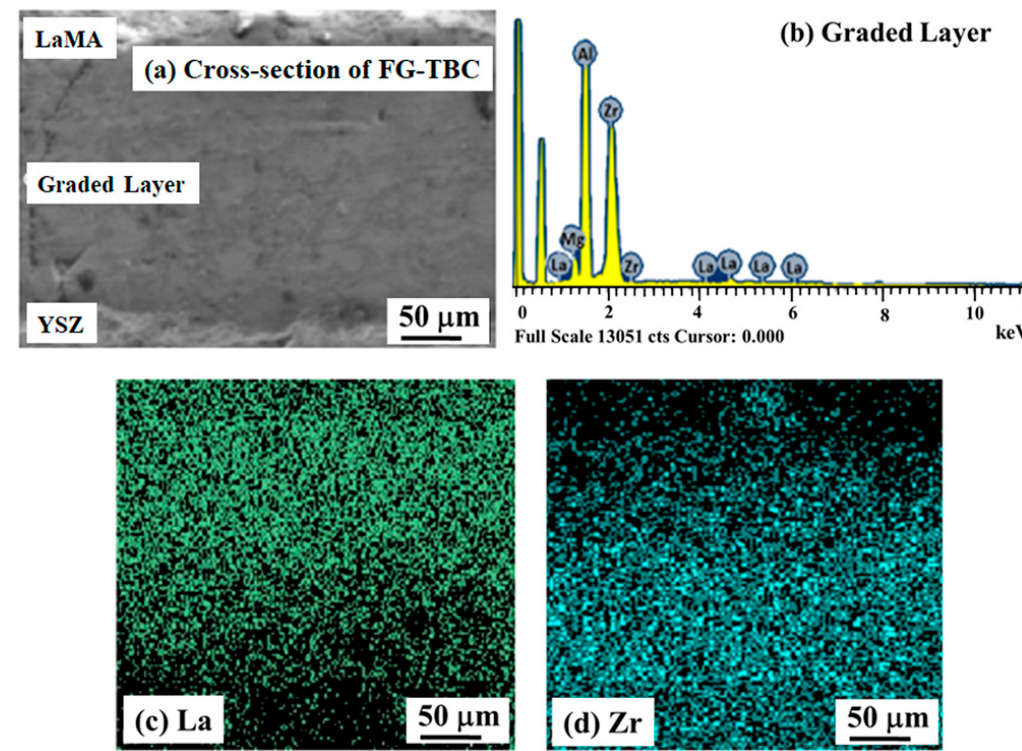
Figure 8. ( a ) SEM image of the cross-section of FG-TBC. ( b ) EDS spectrum across the graded layer showing the presence of La, Mg, Zr and Al elements. ( c , d ) Elemental maps showing the gradual variation of La and Zr across the coating thick-ness.